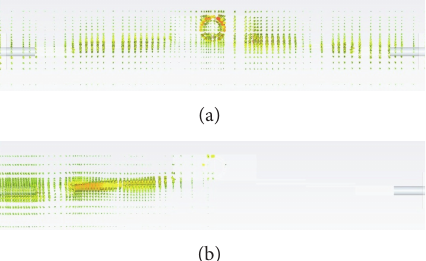
Figure 5: Surface current density plots obtained by full wave simu- lation: (a) operation in the passband region of the filter, at 3.6 GHz; (b) operation in the stopband region of the filter, at